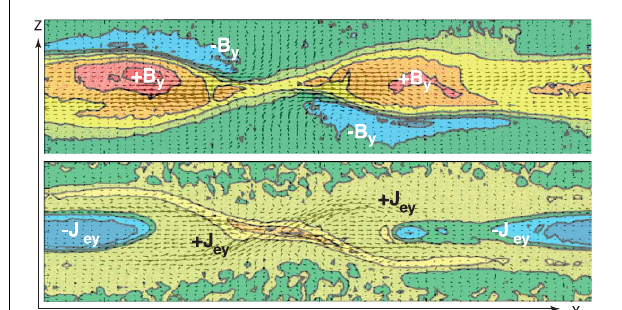
FIGURE 12 | Guide field reconnection. Top: Ion velocity (arrows) overlaid by the out-of-plane magnetic component of the magnetic field [simulation data after 138, courtesy American Geophysical Union]. This field includes the guide field B yg and the self-consistent Hall field. The guide field causes an asymmetry in the field and ion flows. The diffusion region becomes tilted. Bottom: The highly asymmetric electron flow pattern overlaid by the out-of-plane electron current J ey which is opposite to the out-of-plane electron flow. Yellow-to-red colors indicate positive, blue-to green colors negative values. The electron current is mainly in + y direction along the induction electric field. It is highest along the yellow-red diagonal, indicating that it has been accelerated along the reconnection amplified convection electric